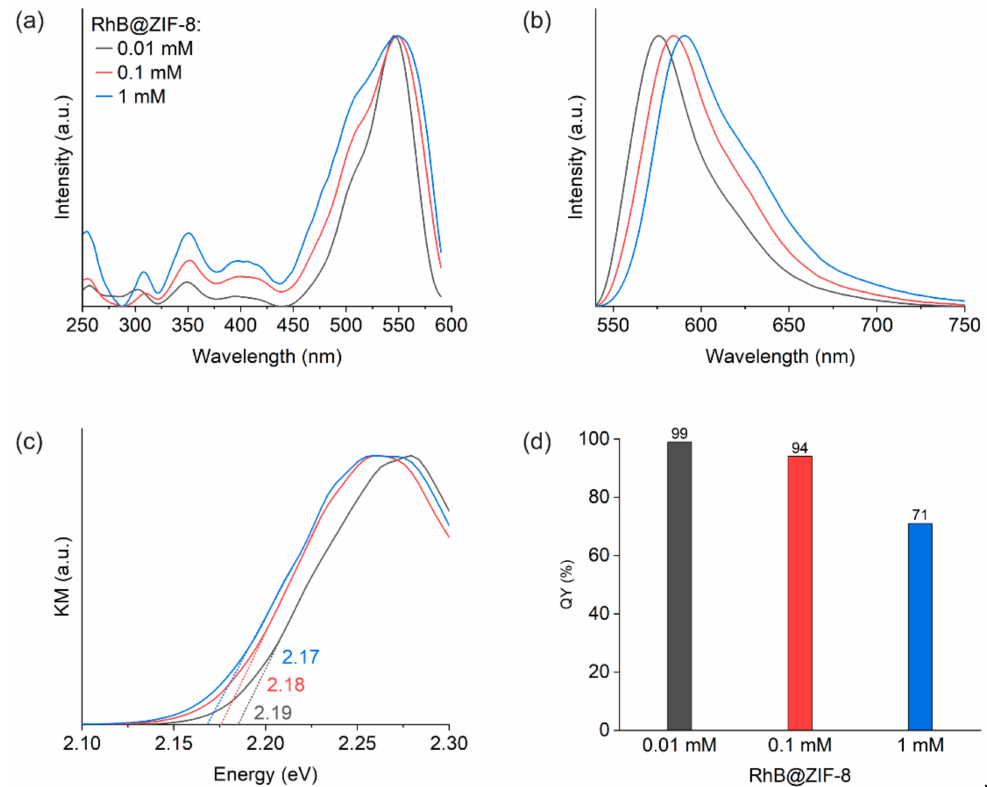
Figure 2. ( a ) Normalized excitation spectra (observed at emission wavelength of 610 nm). ( b ) Normalized emission spectra (observed at excitation wavelength of 520 nm). ( c ) Optical band gaps estimated from the Kubelka–Munk (KM) function for RhB@ZIF-8, employing data measured by diffuse reflectance spectroscopy. ( d ) Quantum yield (QY) of the solid-state